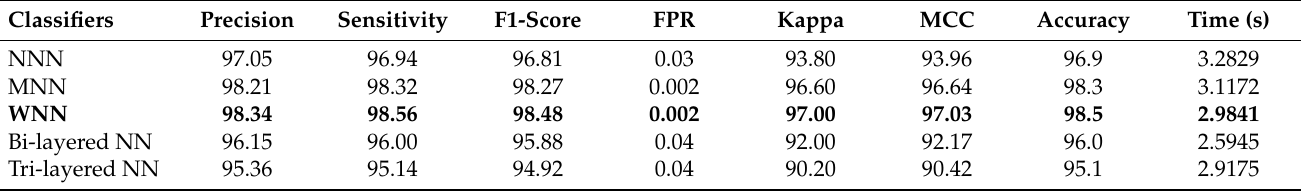
Table 6. Proposed feature optimization results on COVID-19 Patients Lungs X-ray